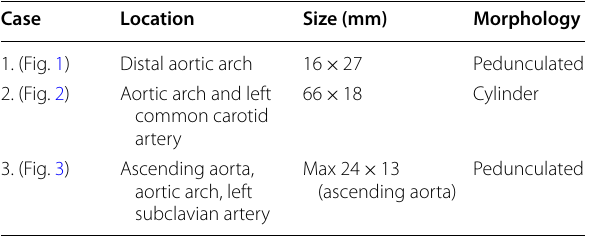
Table 3 Details of the three patients’ free-floating